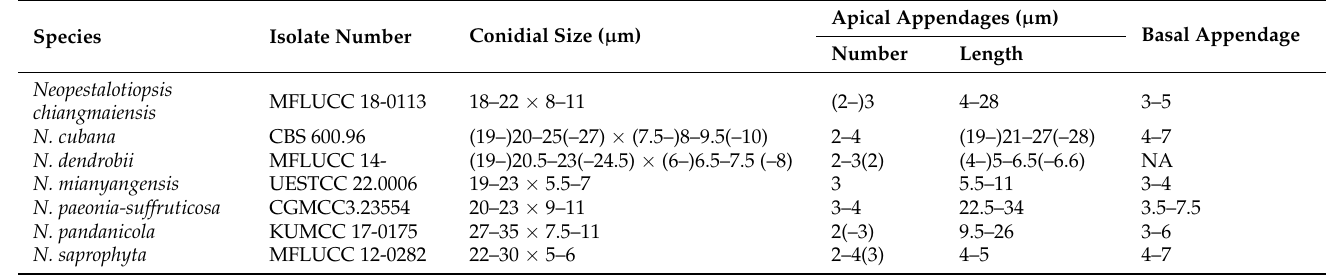
Table 2. Comparison of the conidial dimension of Neopestalotiopsis species related to this study. Species Isolate Number Conidial Size ( µ m)